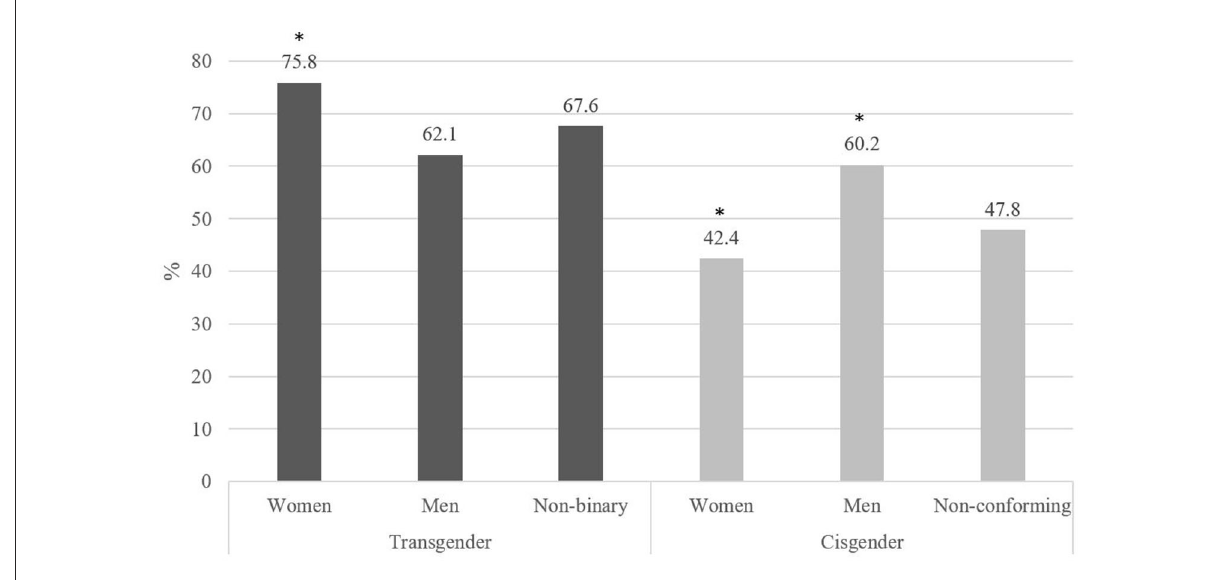
FIGURE1 Percentage of harassment by gender identity.